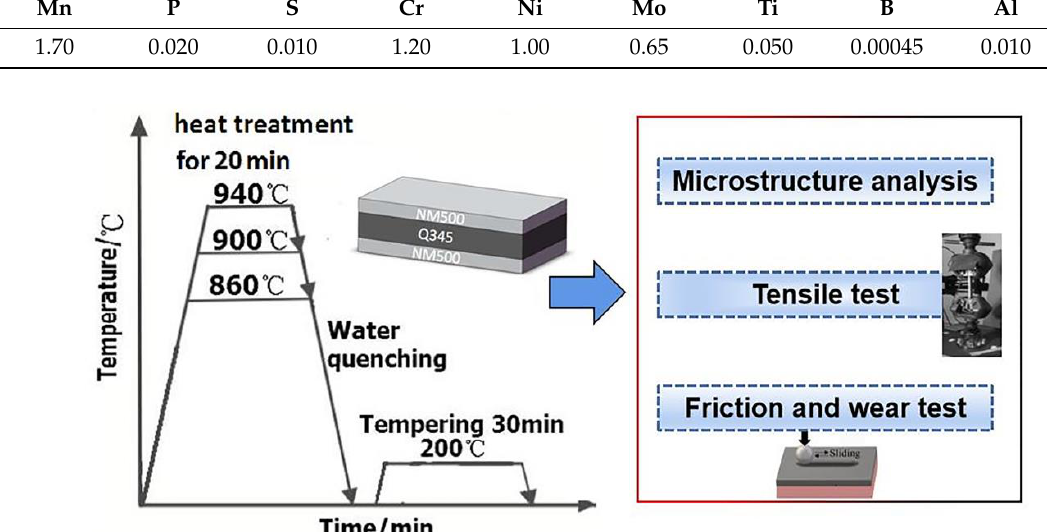
Figure 1. Schematic diagram of the experimental flow.